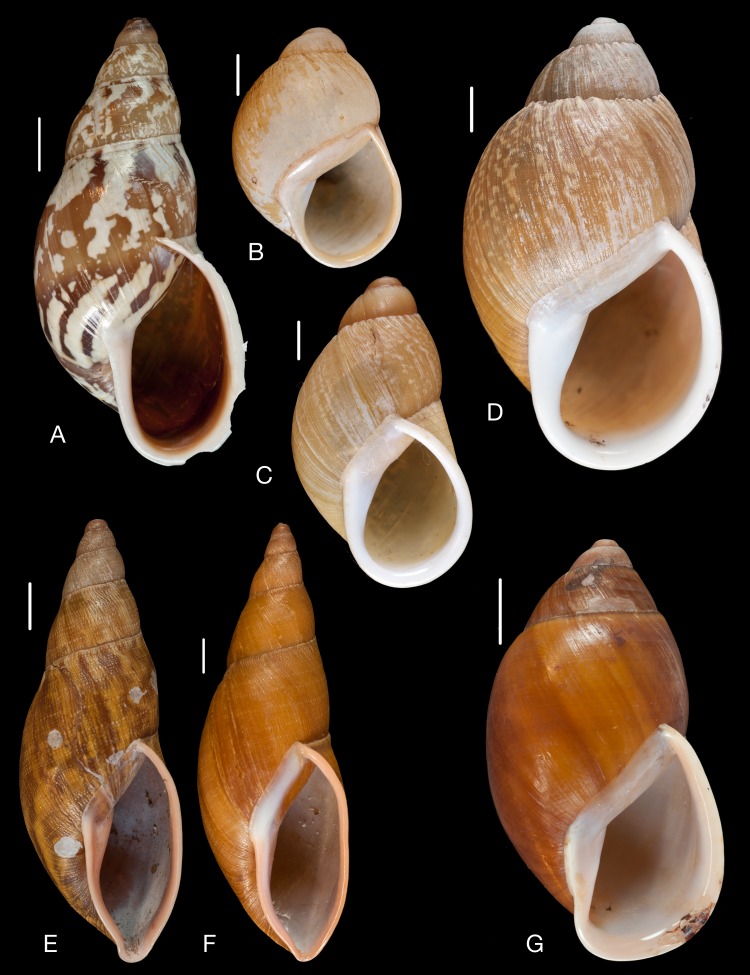
Material collected by the CCP.(A–G) Strophocheilidae. Anthinus multicolor (Rang, 1831), MNCN 15.05/13268, (A) ventral view; Austroborus lutescens (King & Broderip, 1831), MNCN 15.05/13671, (B) ventral view; Chiliborus chilensis (Sowerby I, 1833), MNCN 15.05/13479, (C) ventral view; Chiliborus rosaceus (King & Broderip, 1831), MNCN 15.05/13269, (D) ventral view; Gonyostomus egregius (Pfeiffer, 1845), MNCN 15.05/13368, (E) ventral view; Gonyostomus goniostomus (Férussac, 1821), MNCN 15.05/13369, (F) ventral view; Speironepion milleri (Sowerby I in Sowerby I & II, 1838), MNCN 15.05/13298, (G) ventral view. Scale line 5 mm (A–F), 1 cm (G).